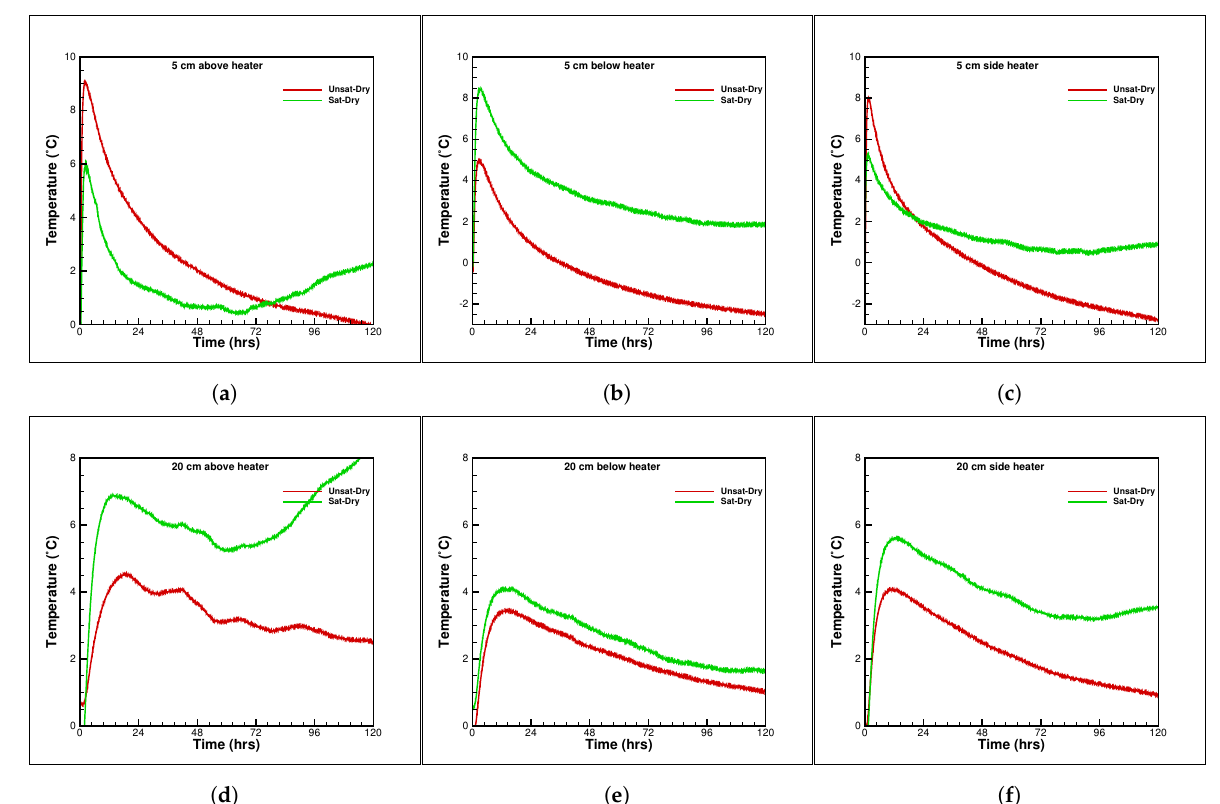
Figure 11. The differences in temperature between the unsaturated-dry and saturated-dry soil conditions at a depth of 5 cm and 20 cm. ( a ) 5 cm of the top surface of heater; ( b ) 5 cm in the horizontal line of heater; ( c ) 5 cm of the bottom surface of heater; ( d ) 20 cm of the top surface of heater; ( e ) 20 cm in the horizontal line of heater; ( f ) 20 cm of the bottom surface of